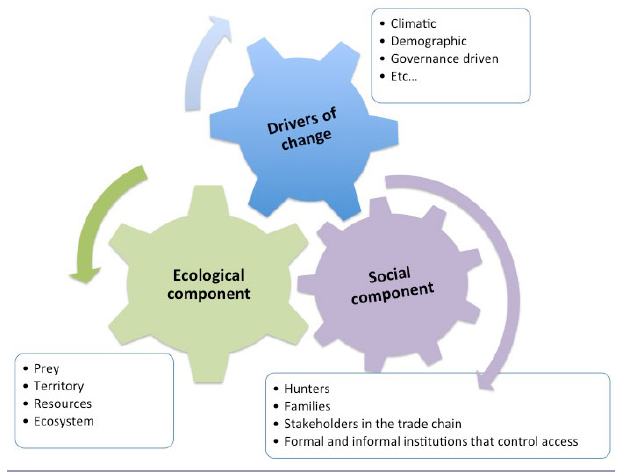
Fig. 1 . Theoretical representation of the social-ecological hunting